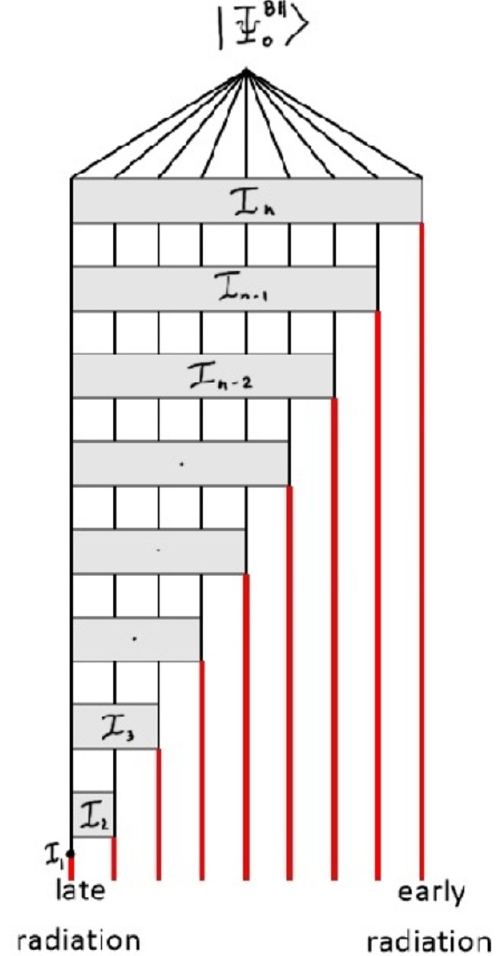
Figure 2 . Tensor network for (cid:12)nal state of black hole radiation. Input state at the top is the black hole initial state, an arbitrary state of a dimension d n Hilbert space, represented as the tensor product of n Hilbert spaces of dimension d (thinner black lines). Each rectangular box represents an isometry. Thicker red lines correspond to D -dimensional tensor product factors of the radiation subsystem each containing one quantum of radiation. Maximally e(cid:14)cient models have D = d and each isometry is a